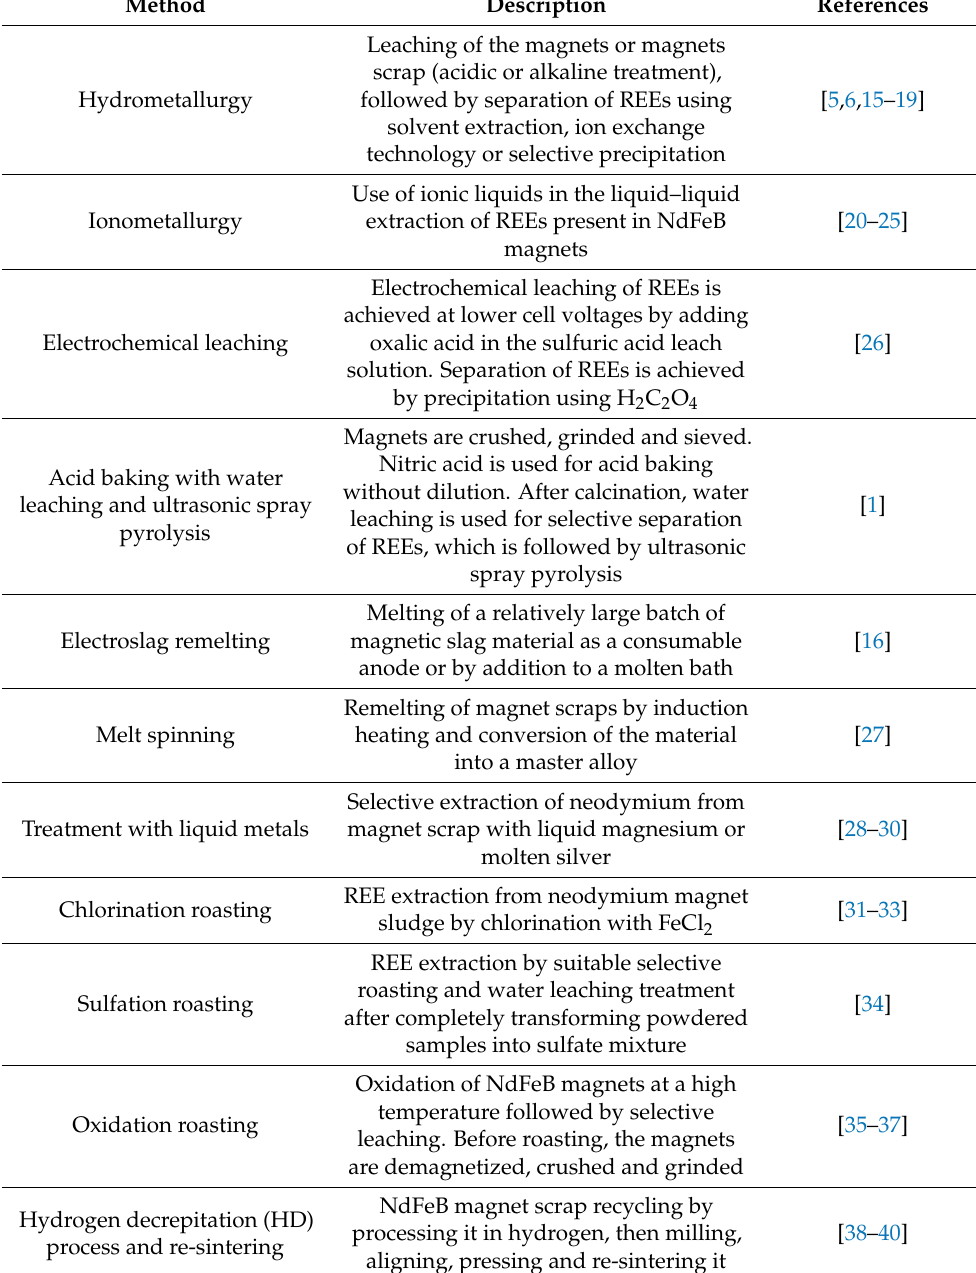
Table 1. Selected methods of recycling of NdFeB permanent